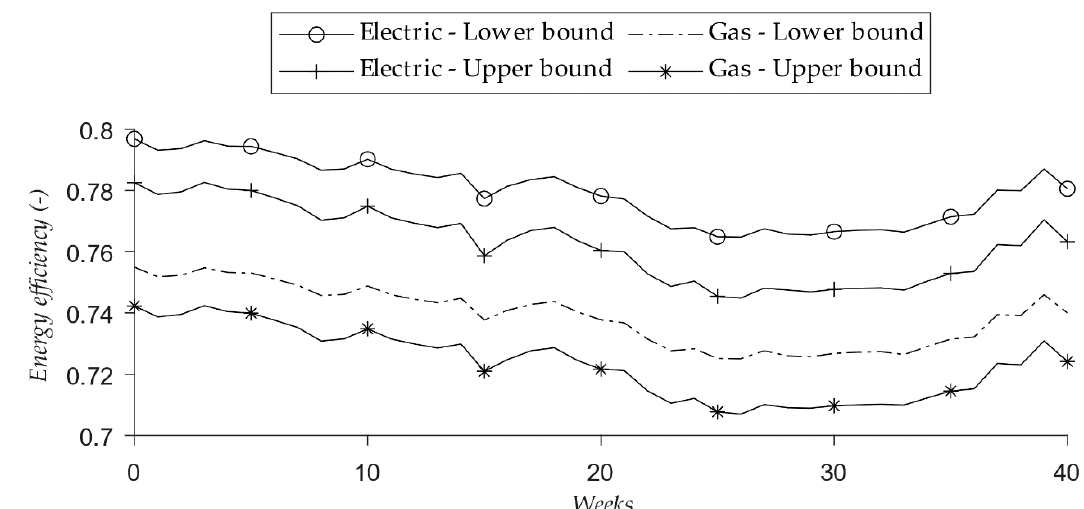
Figure 11. Generation technology and process parameter effects on energy efficiency of the system.